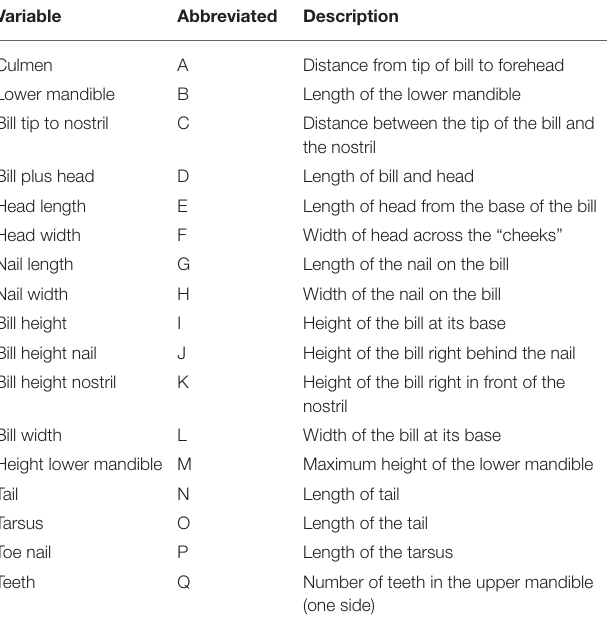
TABLE 2 | Full and abbreviated variable names and a short description of their biological